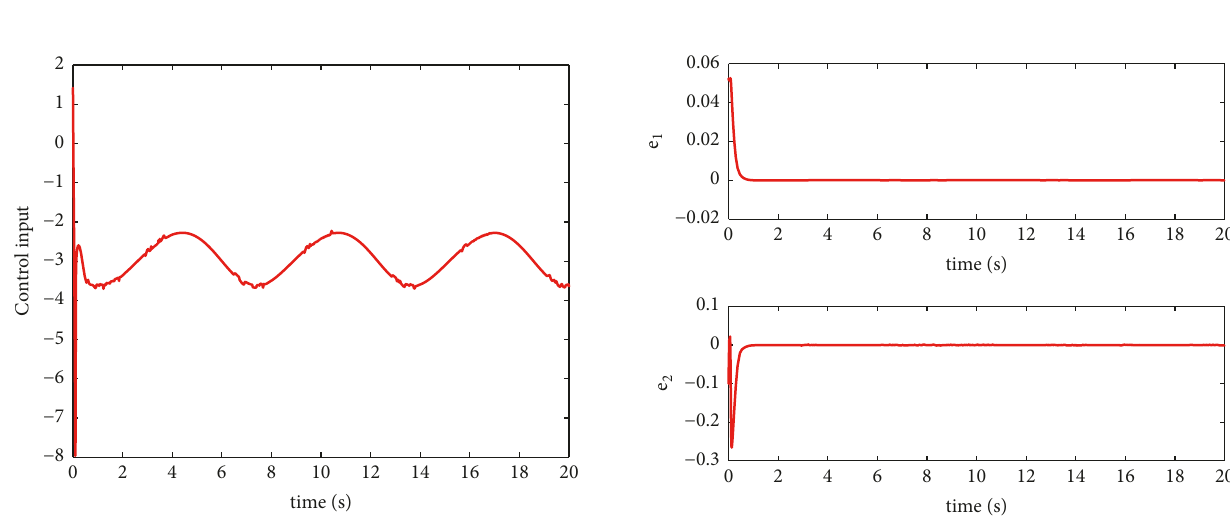
Figure 9: The control results of NNSMC with 𝑥 𝑑 = 0.1 sin (𝑥) .